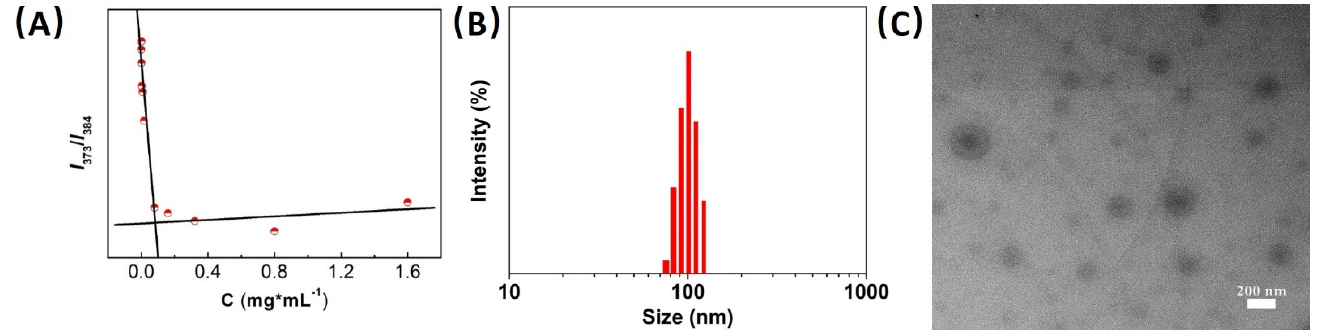
Figure 4. ( A ) Determination of CMC for rhodamine-functionalized mPEG-b-P(PA-alt-AGERh) copolymer micelles (CMC = 0.08348 mg·mL − 1 ); ( B ) DLS profile and ( C ) TEM images of rhodamine-functionalized mPEG-b-P(PA-alt-AGERh) copolymer micelles.